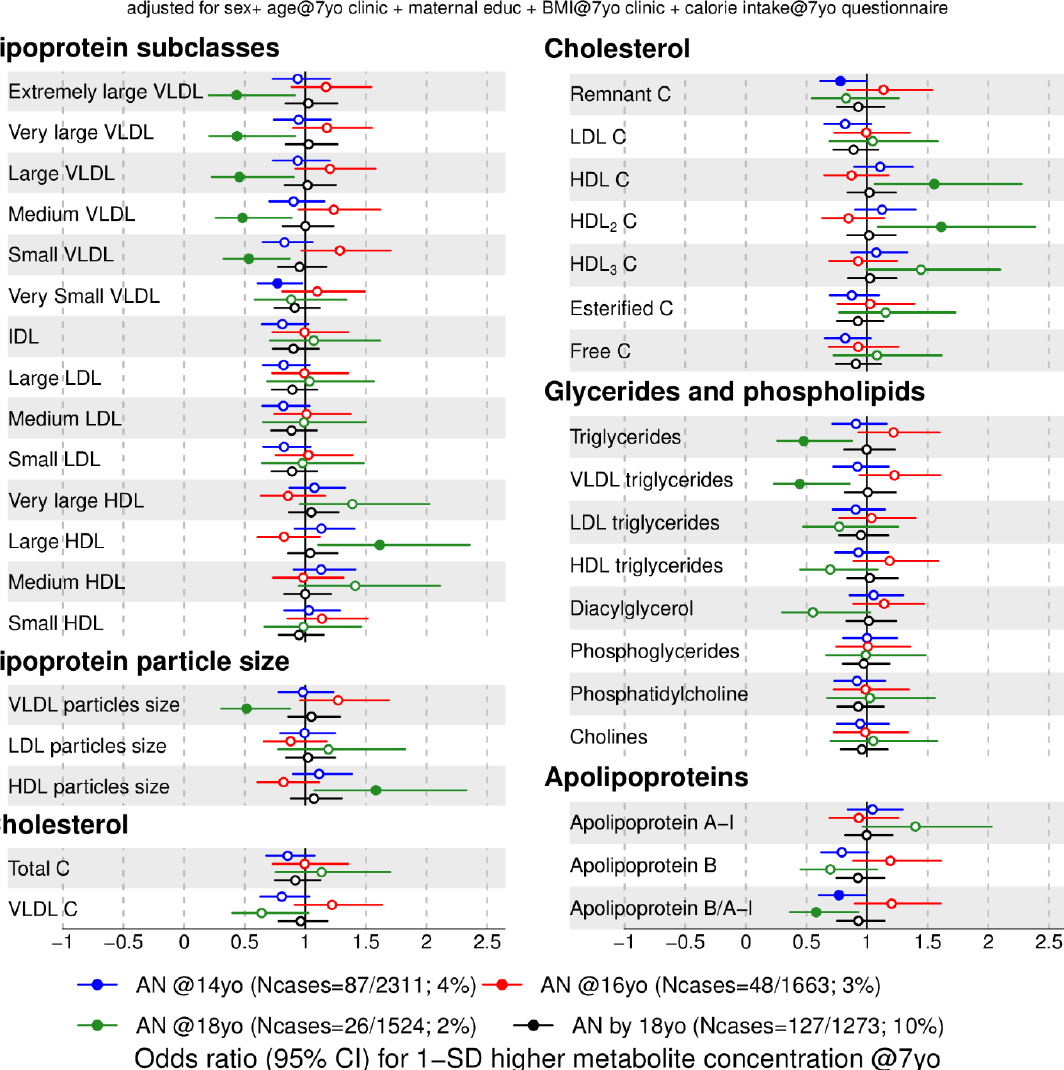
Figure 1. Estimated odds ratios for anorexia nervosa at 14, 16, 18 years of age and cumulatively across all three time points according to lipid-related metabolic trait concentrations at 7 years. Estimates refer to 1 standard deviation increase in metabolic trait concentration at 7 years (see also Table S2, Supplementary File). Error bars = 95% confidence intervals (CI). For lipoprotein subclasses, the total lipids ( = triglycerides + phospholipids + total cholesterol) point estimate (and CIs) of each 14 subclasses is presented. Estimated odds ratios and corresponding 95% CIs for particle concentration and specific lipids in each lipoprotein subclass are given in Figure S1a–c, Supplementary Material and Table S2, Supplementary File. Abbreviations: AN = anorexia nervosa; C = cholesterol; IDL = intermediate-density lipoprotein; LDL = low-density lipoprotein; HDL = high-density lipoprotein; VLDL = very low-density lipoprotein. Note: Filled dot: CI do not include the null.